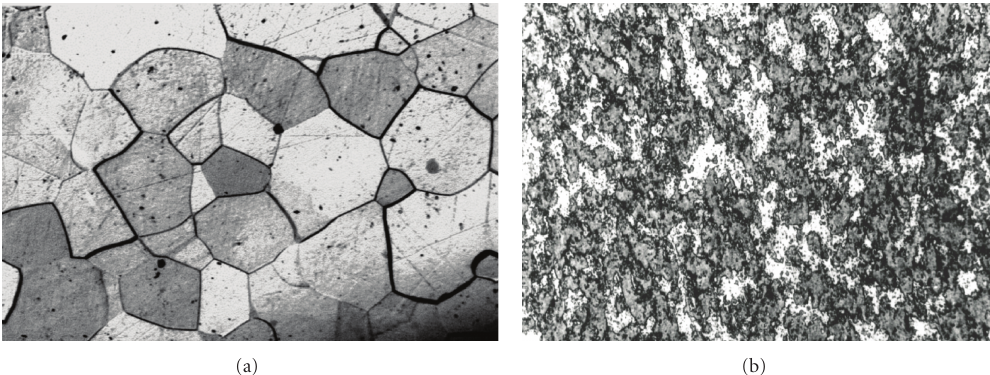
Figure 5: Photomicrographs of the Ti (a) and the dental implant, Ti-grade 2 (b), surfaces etched with the Kroll reagent (200x).